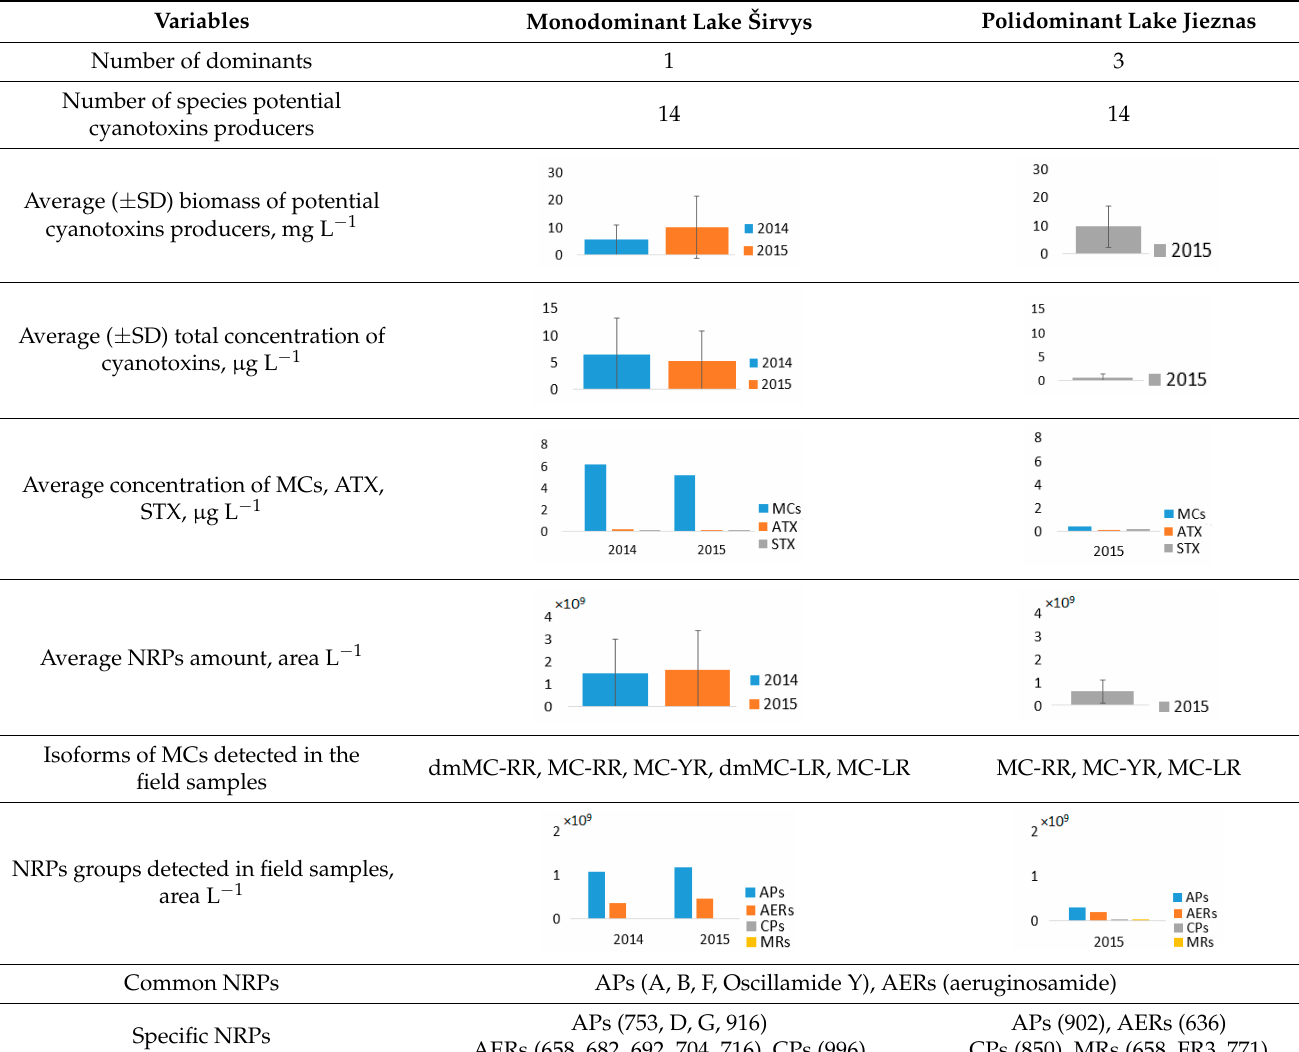
Table 3. Summarized data on cyanobacteria, cyanotoxins and other NRPs of mono- and polidomi- nant